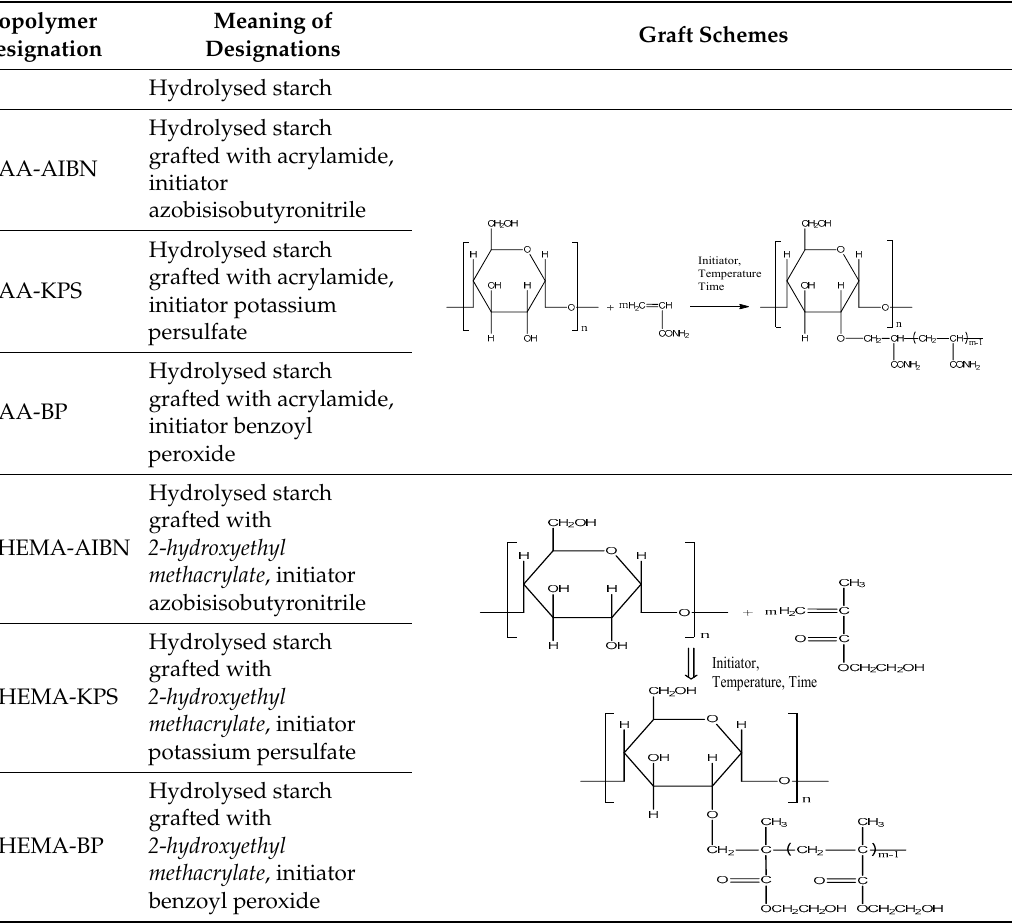
Table 1 lists the designations of the copolymers obtained after graft copolymerization onto starch. When copolymerizing with AIBN, KPS, and BP initiators, the grafted branches are bonded with the starch skeleton via oxygen, because graft copolymerization is initiated by the release of active hydrogen from the starch hydroxyl [47]. Table 1. Designations of the obtained copolymers, their meaning and content of the recipe per yarn types.